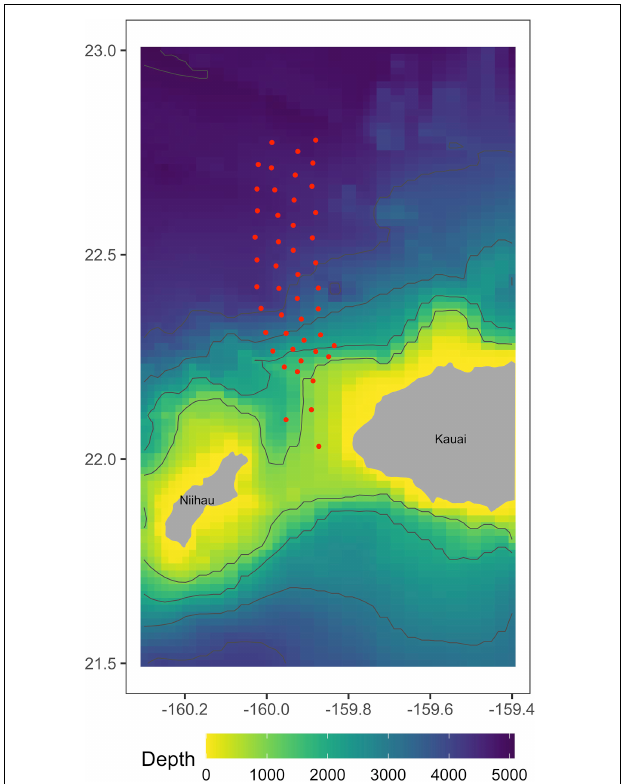
FIGURE 1 | Approximate locations of 47 recorded broadband hydrophones at the Pacific Missile Range Facility in Kauai, Hawaii. These hydrophones have the frequency response necessary to detect minke whale boing